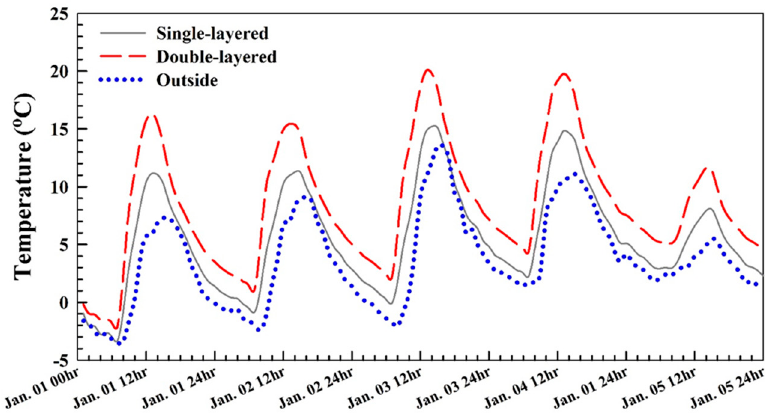
Figure 13. Variation in internal greenhouse air temperatures (from 1–5 January 2016) of greenhouse covered with single and double ‐ layered PE material.